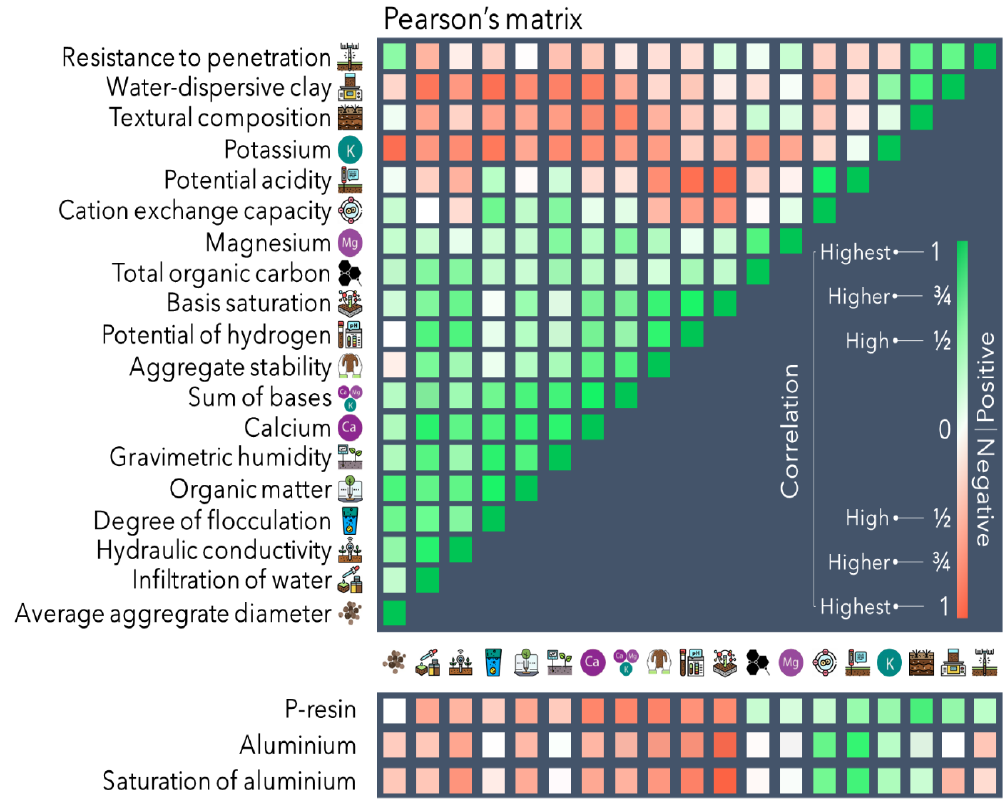
Figure 4. Correlogram for indicators of recuperative performance.